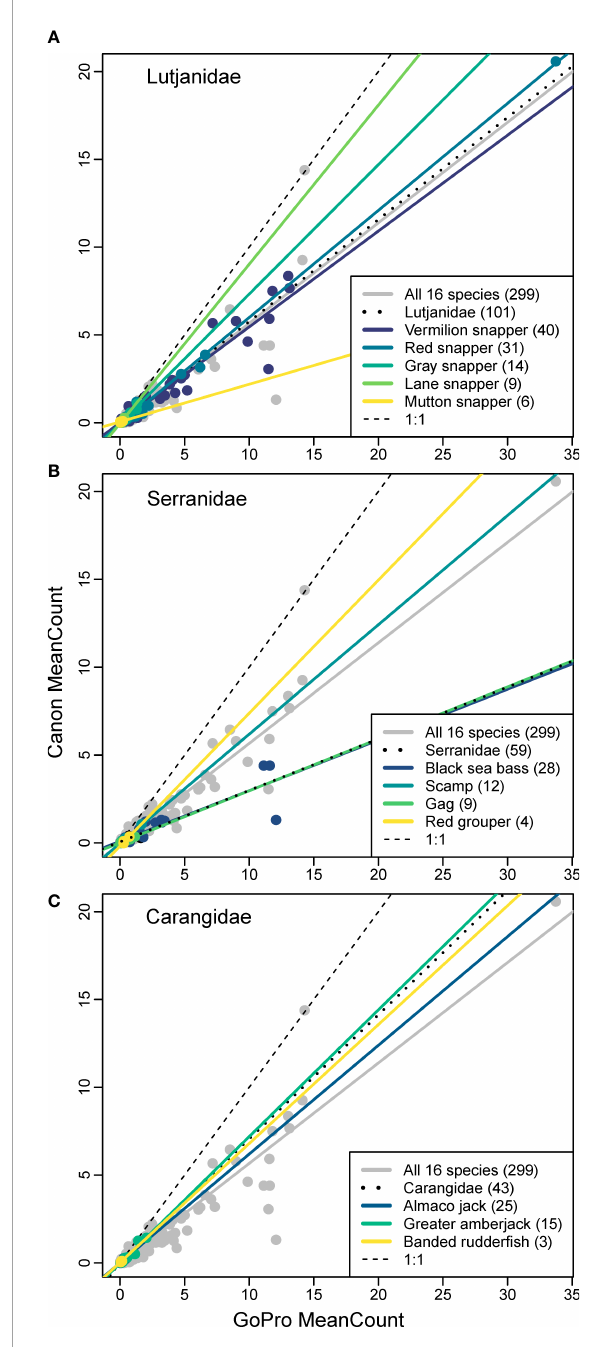
FIGURE 5 Calibrations between Canon Vixia HF-S200 and GoPro Hero 3+ cameras for various species within three families (A) Lutjanidae; (B) Serranidae; (C) Carangidae from data collected by the Southeast Reef Fish Survey along the southeast United States Atlantic coast in 2014. The overall calibration is shown in gray, family level calibrations are shown by black dotted lines, species ’ calibrations are shown by solid colored lines, and the 1:1 relationship is indicated by thin black dashed line. Number in legend indicates sample size for each taxa.